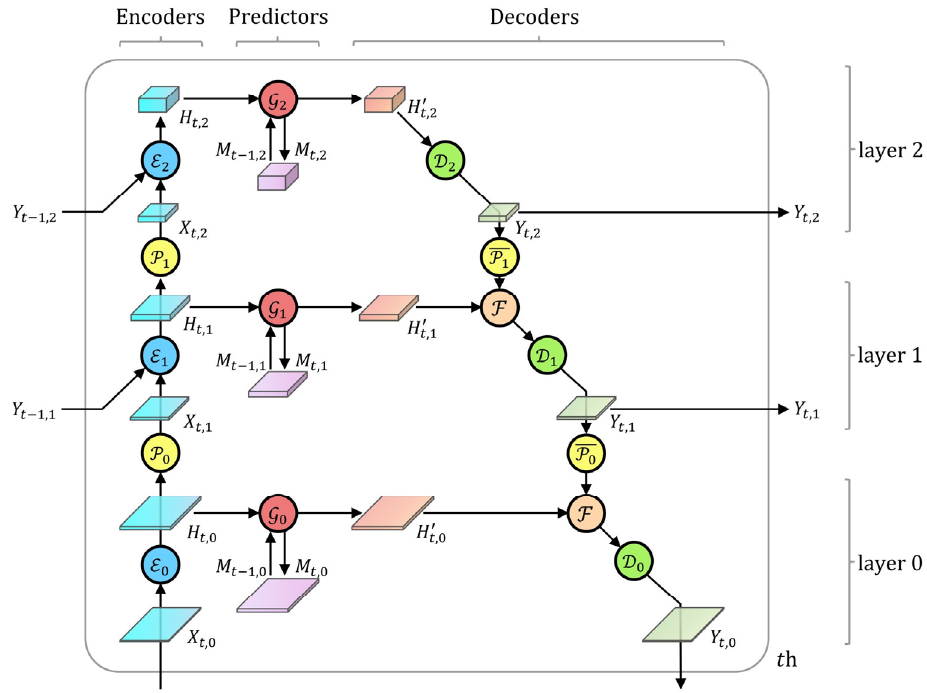
Figure 4. Proposed hierarchical graph convolutional network as the sequence prediction part of HDGN. Schematic shows the detailed structure of a three-layer network, where circles are components and rectangles are data. A rectangle’s bottom area and height characterize the size of graph and feature space, respectively.